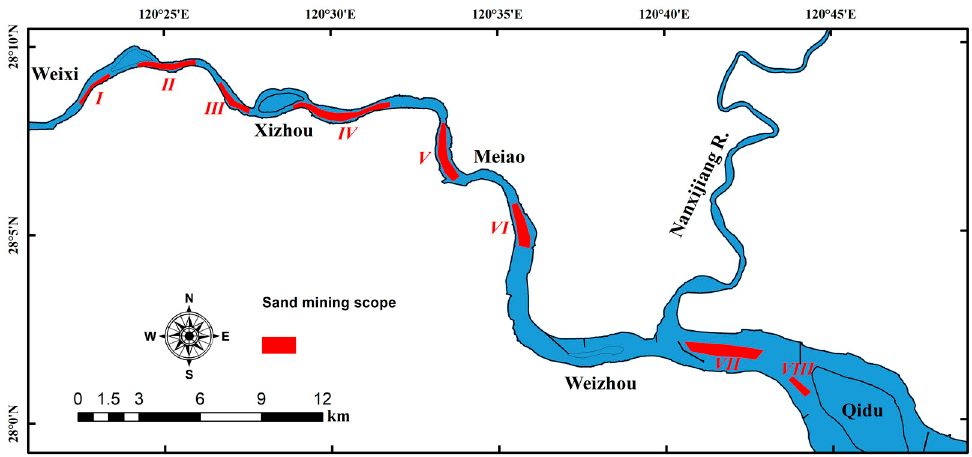
Figure 9. Distribution Map of Estuarine Sand Mining in 2012–2019.